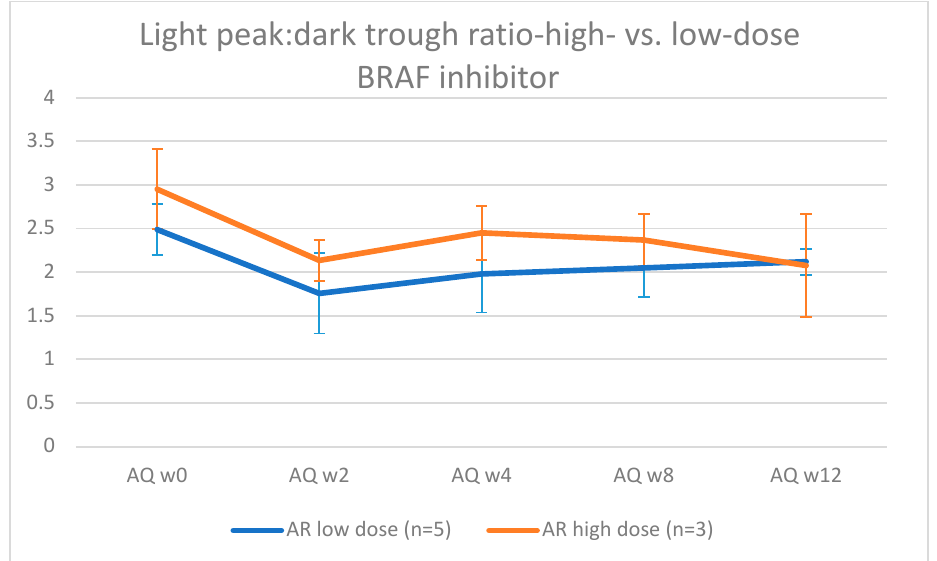
Figure 4. Visual representation of the evolution of light peak:dark trough ratio in eyes treated with a low (50 mg/day) vs. high dose (150 mg/day) of dabrafenib. The low-dose group comprises nine eyes from five patients. The high-dose group comprises six eyes of three patients. The patient who developed a MEKAR belonged to the low-dose group. The error bars represent the standard